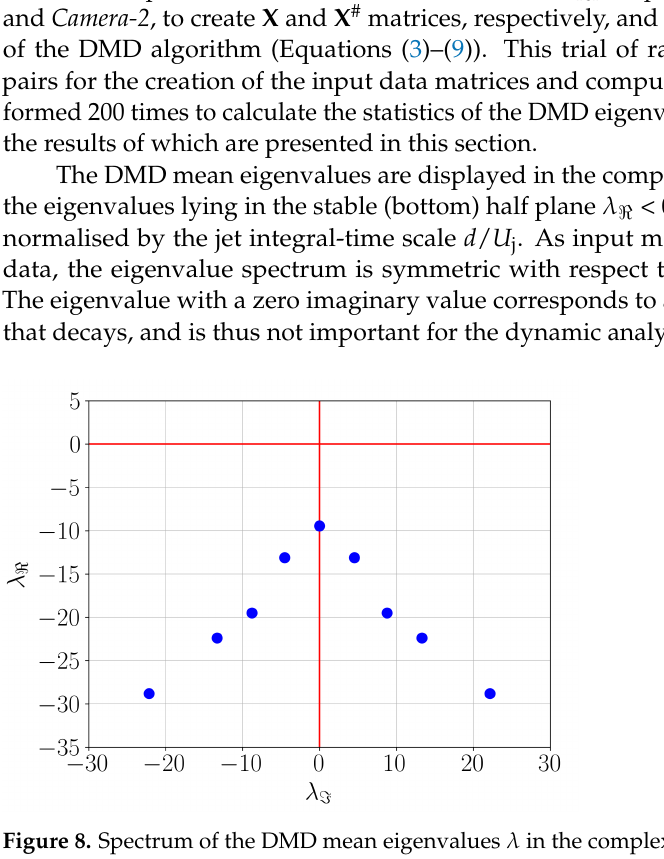
Figure 8. Spectrum of the DMD mean eigenvalues λ in the complex